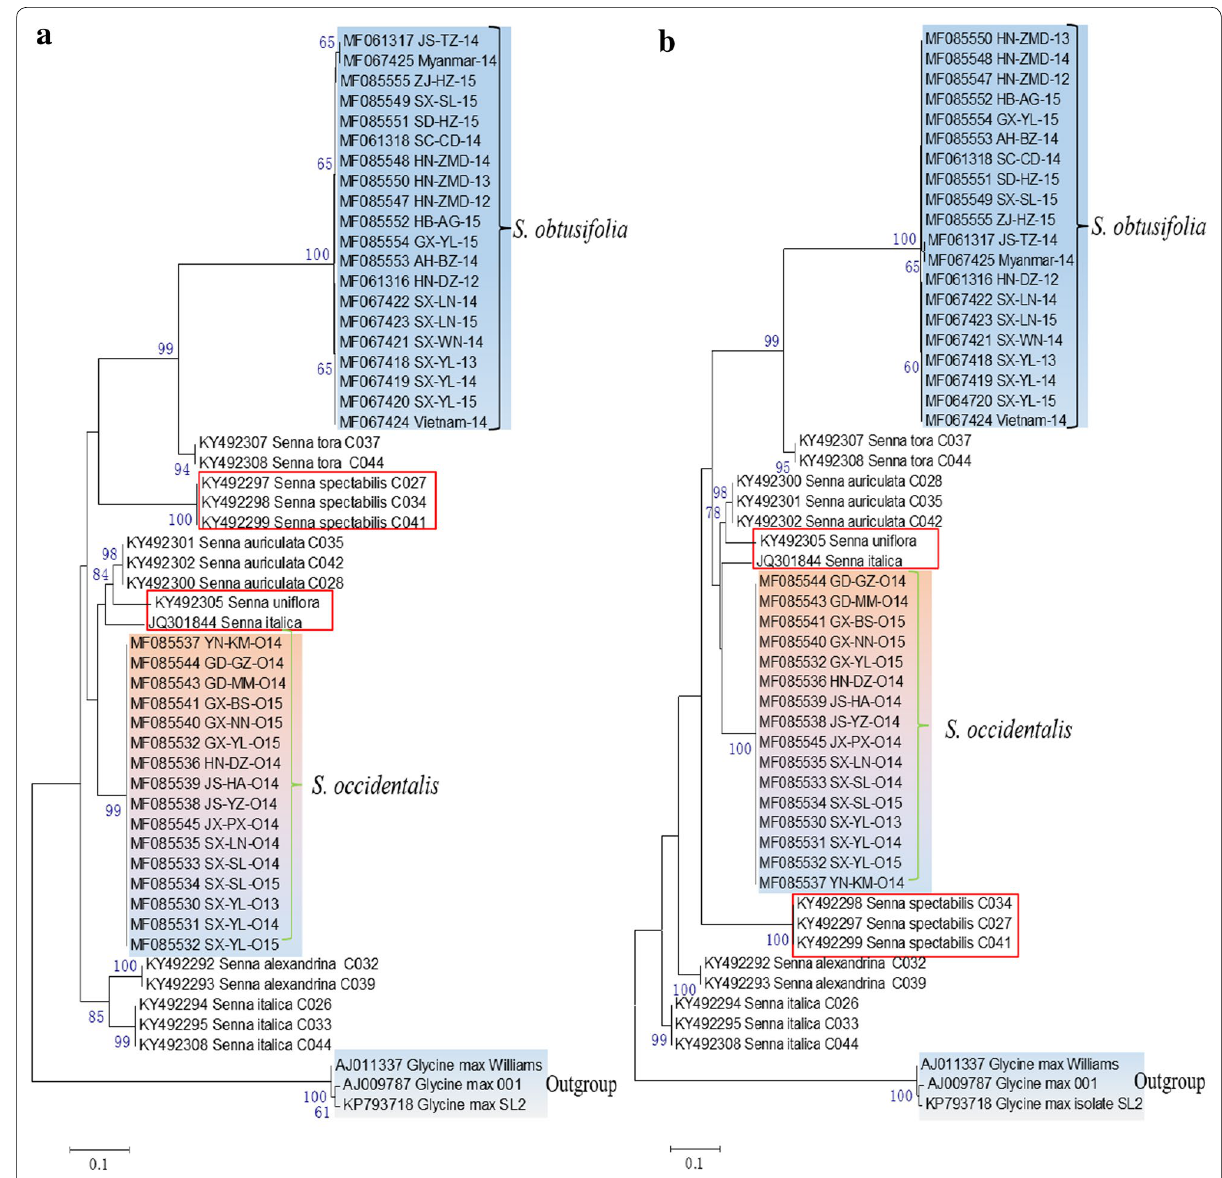
Fig. 3 Neighbour-joining ( a ) and Maximum-likelihood ( b ) phylogenetic trees were constructed based on ITS2 sequence with 1000 replicates. The blue, pink and light blue represented S. obtusifolia, S. occidentalis and Glycine max samples, respectively. The samples differently grouped in two phylogenetic trees were highlighted in the red